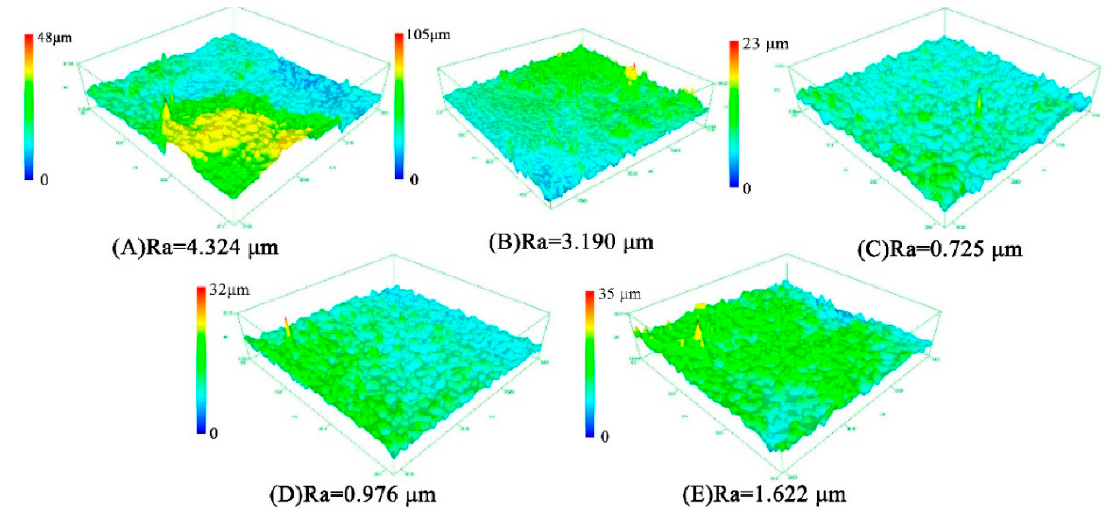
Figure 8. 3-D surface topography images of the HAp layers electrodeposited using DC at various times: ( A ) 60, ( B ) 75, ( C ) 90, ( D ) 105, and ( E ) 120 min [113].